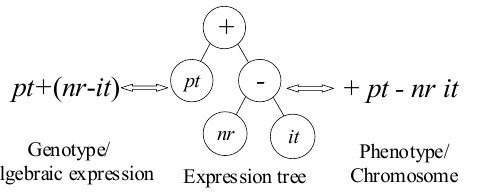
Figure 3. The mutual transformation of genotype and phenotype.